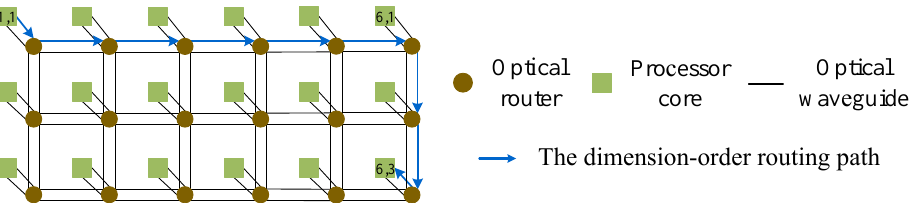
Figure 4. Example: The dimension-order routing path when the optical signal travels from processor core (1, 1) to processor core (6,